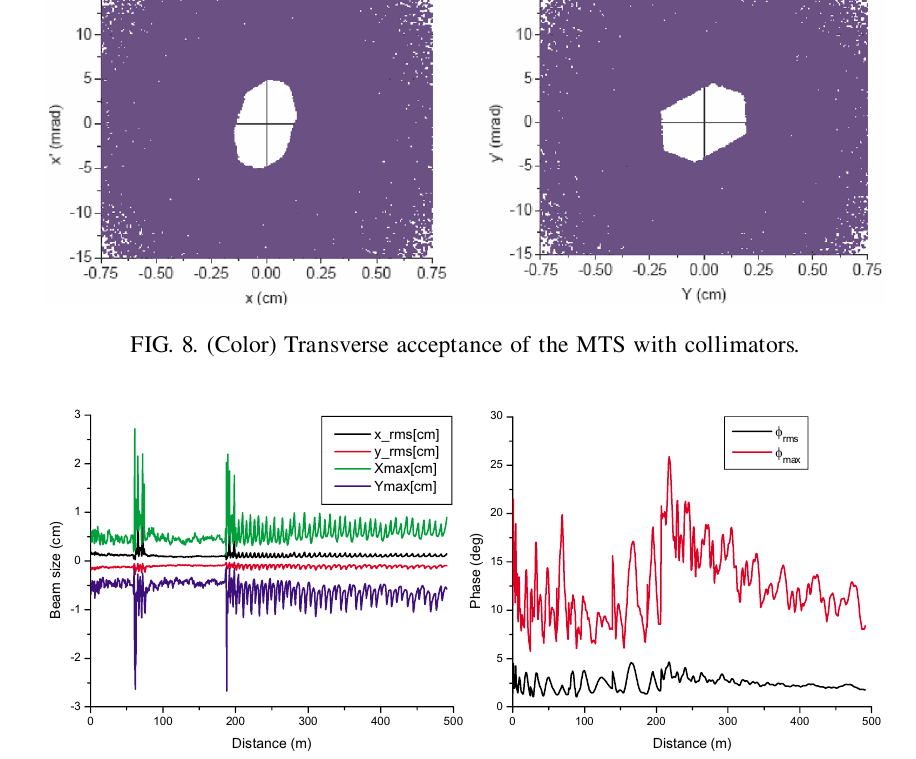
FIG. 9. (Color) Transverse and phase rms and maximum sizes along the driver linac. The vertical beam sizes are shown with a negative sign. The bunch phase width is shown in degrees of the corresponding frequency which is changing along the linac from 57.5 to 805